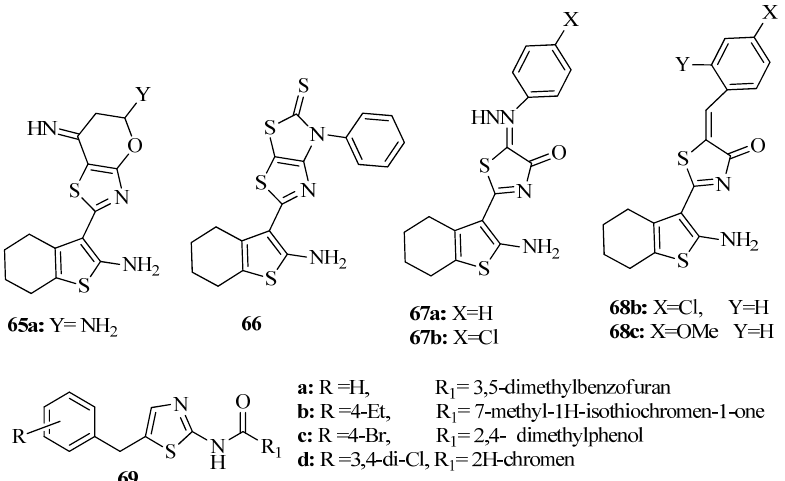
Figure 26. Structures of 2-amino-4,5,6,7-tetrahydrobenzo[b]thiophene-3-carbonitrile and N acylated 2-amino-5-benzyl-1,3-thiazoles.